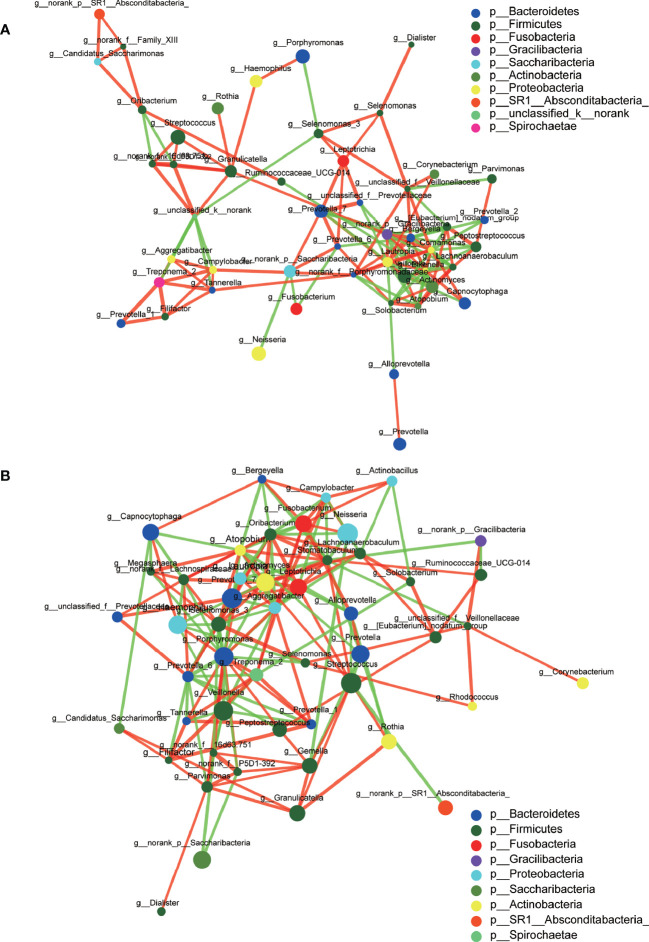
Co-occurrence networks of the top 50 abundant genera in the Abnormal (A) and Normal (B) Groups. The size of the node indicates the mean relative abundance of the corresponding genus. The same color represents the genera belonging to the same phylum. The thickness of connecting lines corresponds to the coefficient values. The red and green lines indicate a positive and negative correlation, respectively.